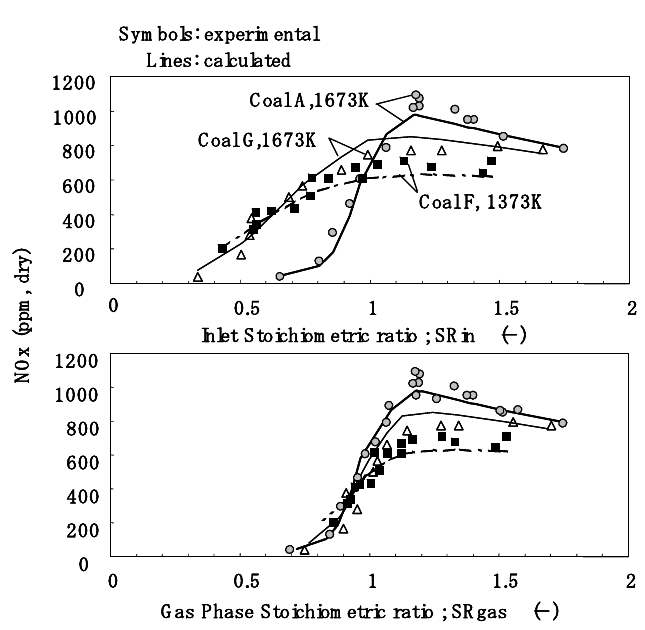
Figure 4. Effect of coal properties and burning temperature on NO are experimental results and lines are calculated results.